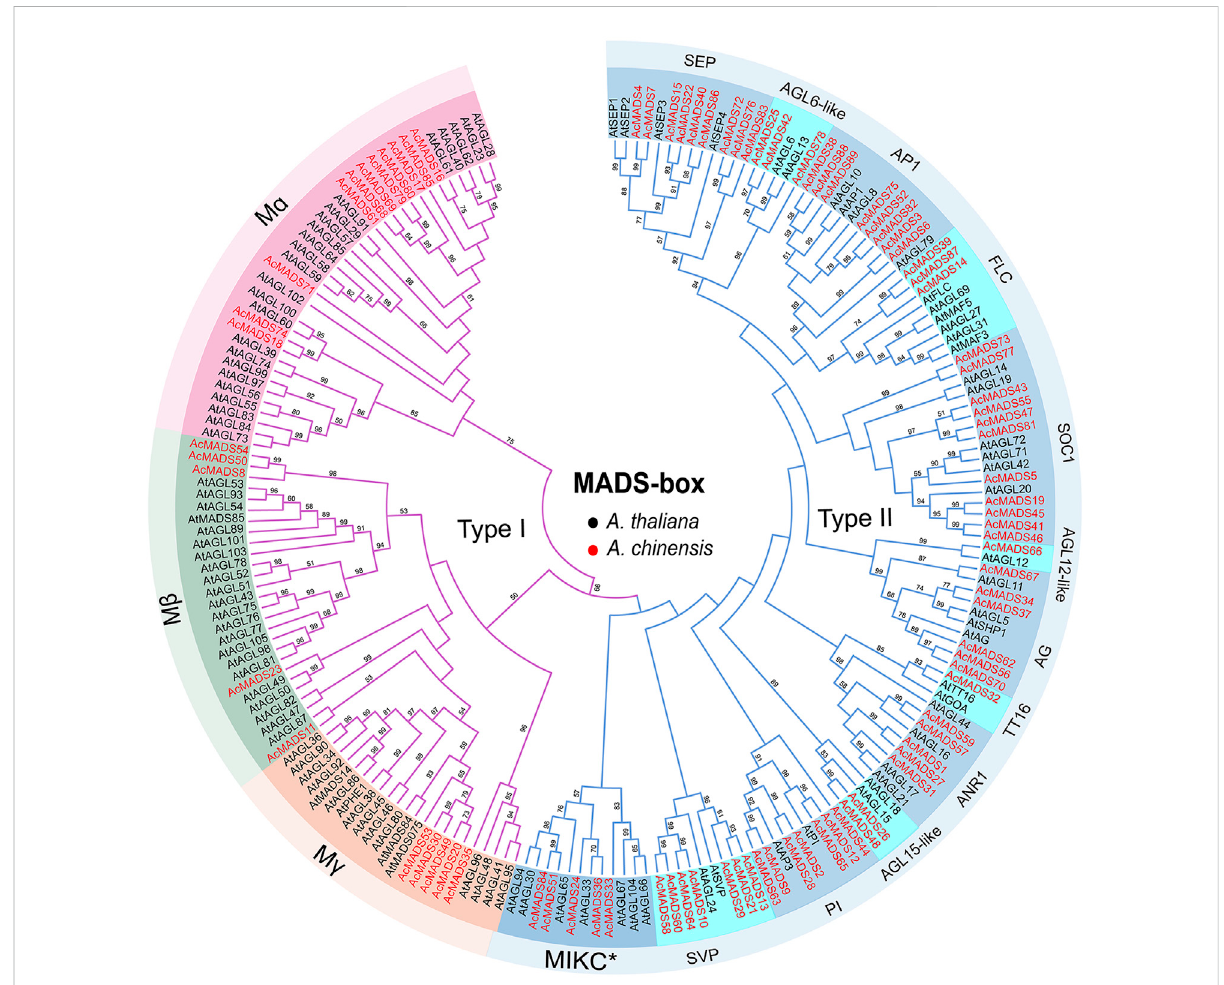
FIGURE 2 UnrootedPhylogenetictreeof A.chinensis and A.thaliana MADS-boxgenes.TheMADS-boxgene ’ snamesareindicatedwithdarkandredfor A. thaliana (109) and A. chinensis (89), respectively. The purple and blue lines represent type I and type II MADS-box proteins. The names in the outside circle indicate different subgroups. The numbers above the line are bootstrap values, and the bootstrap values less than 50 are not